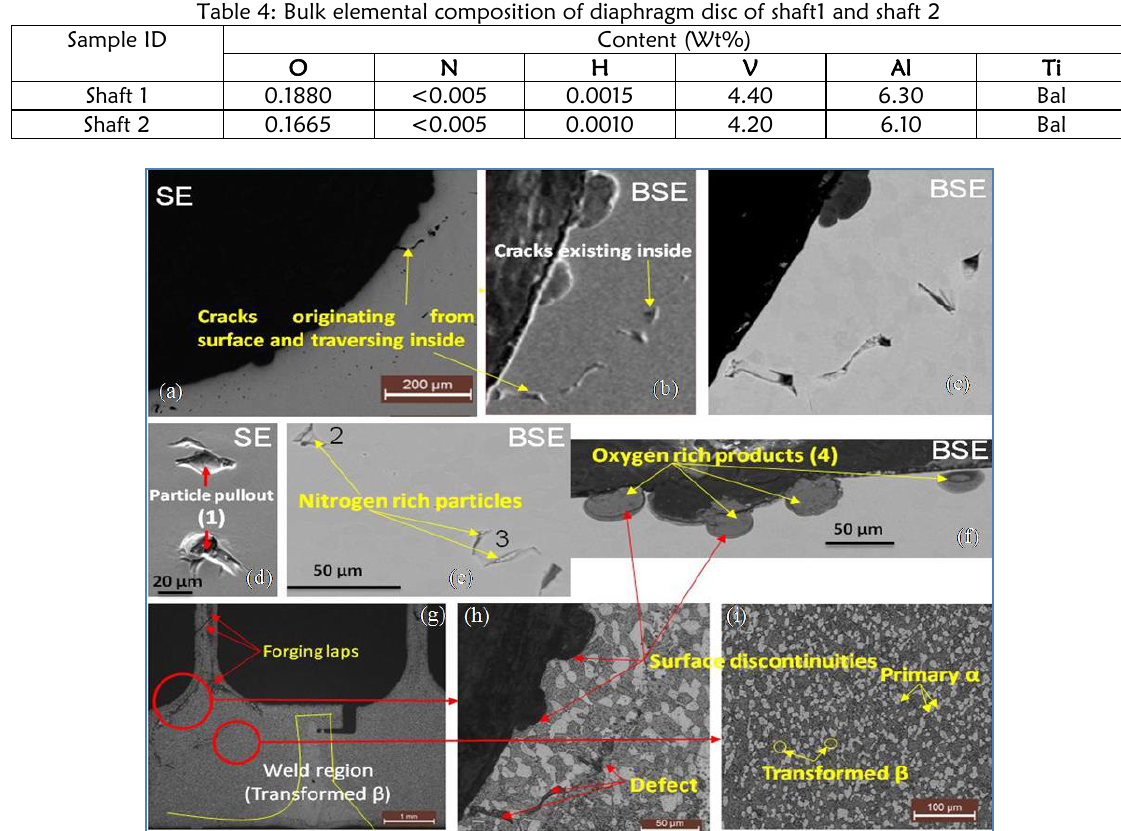
Table 4: Bulk elemental composition of diaphragm disc of shaft1 and shaft 2